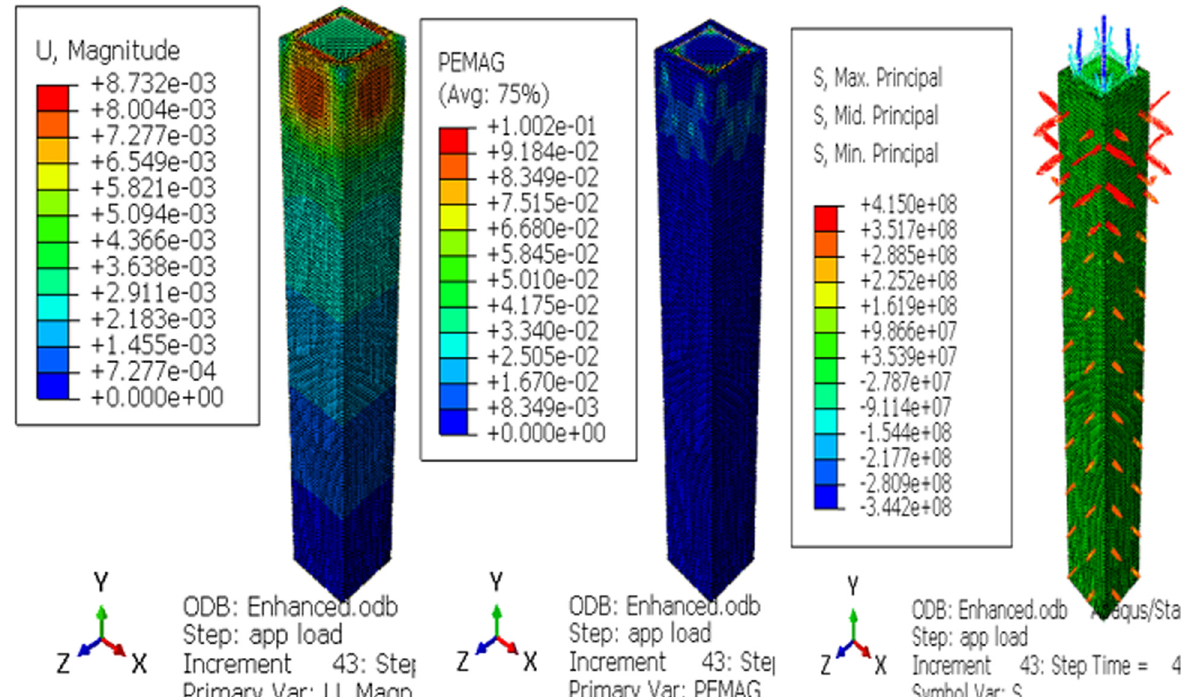
Figure 18: Changes in displacement, stress and plastic strain ( PEMAG ) for strengthened RC